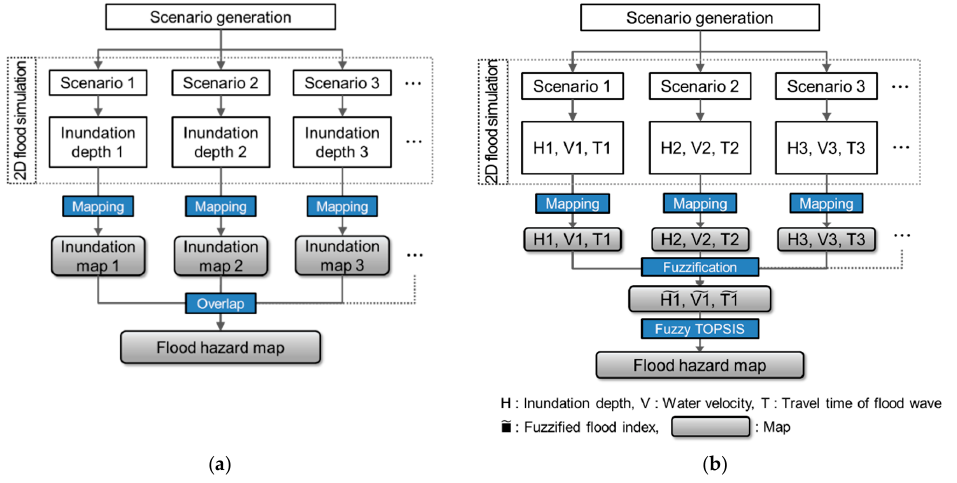
Figure 2. Methodologies for flood hazard mapping: ( a ) Traditional and ( b ) Proposed